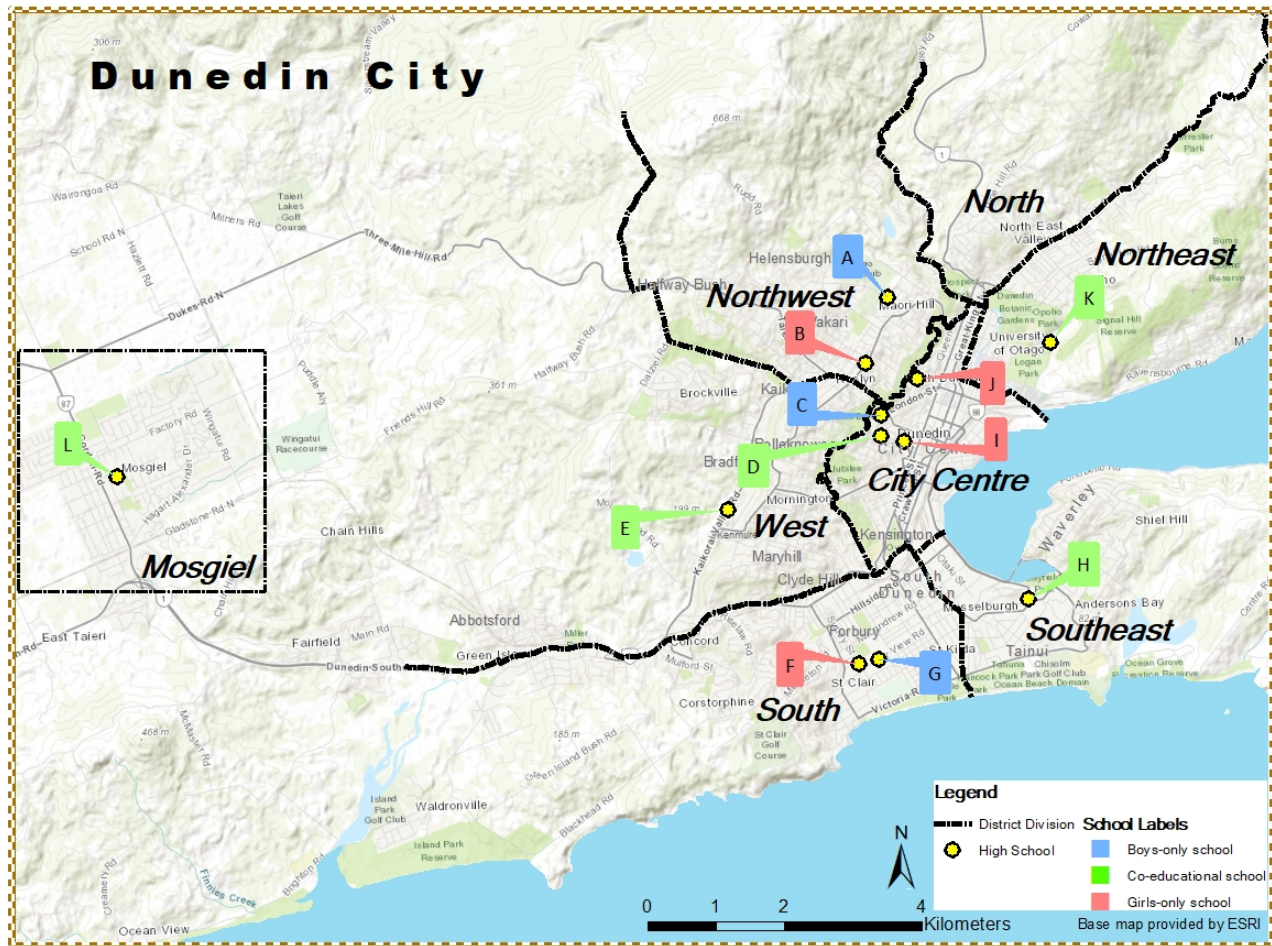
Figure 1 . City areas with important streets, suburbs, districts, and 12 high schools in Dunedin